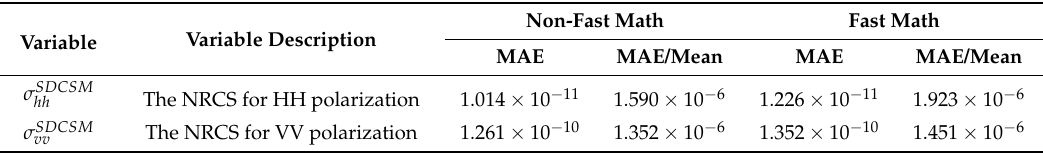
Table 4. The results of mean absolute error (MAE) and MAE/mean with and without the –use_fast_math compiler option.